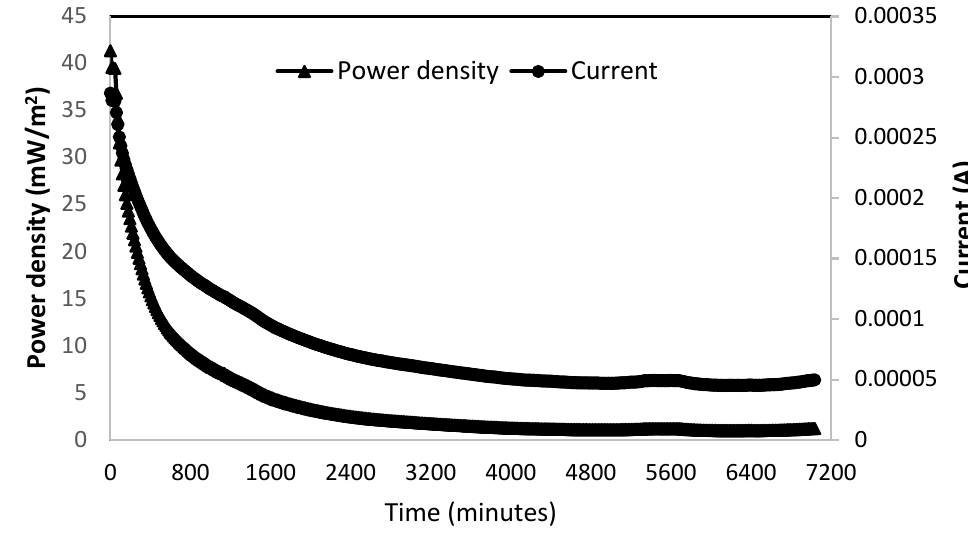
Figure 7. Power density and current generated by MFC from BW digestate-feeding.